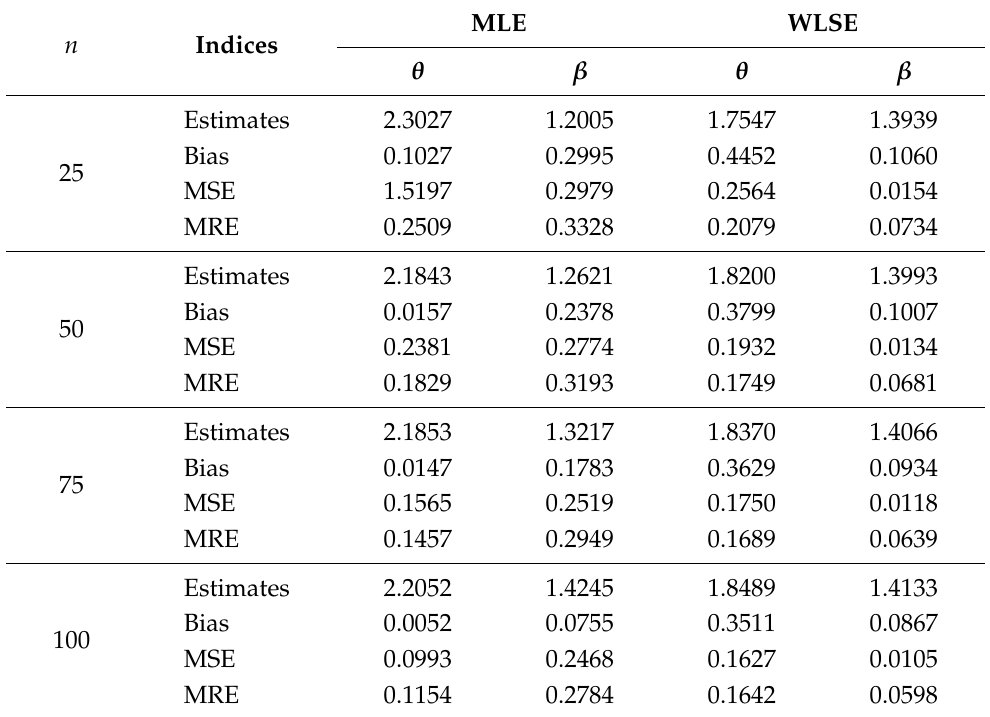
Table 7. Simulation results of our estimation approaches for the DPsL distribution with θ = 2.2, β =